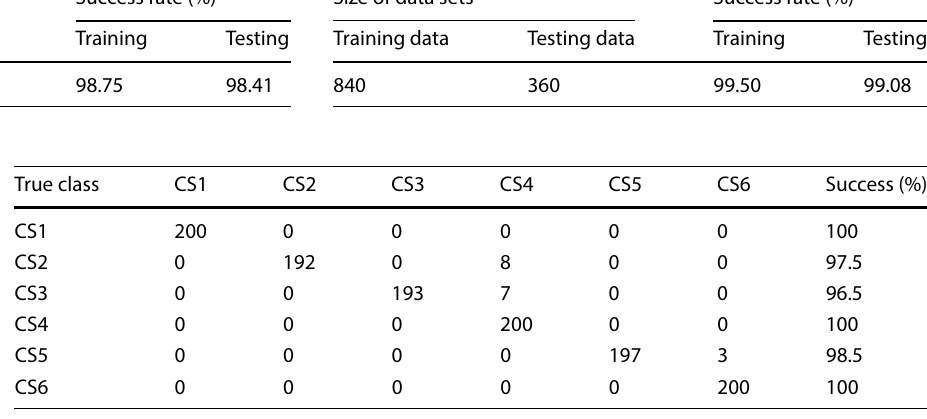
Overall success rate (%):